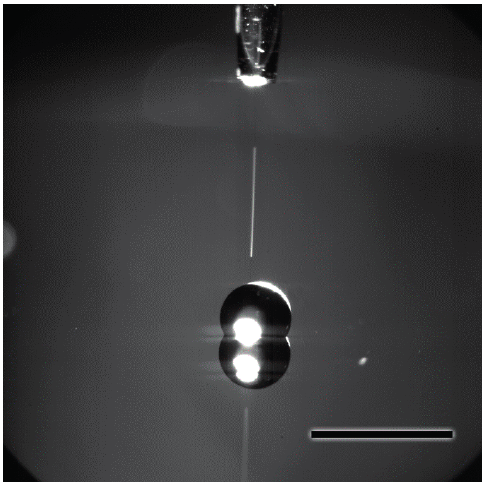
Figure 1. Image showing an optical microscope image of a single inkjet droplet (trail) being ejected from the inkjet printer head (top) onto the FTDS treated silicon substrate. The larger ensemble droplet on the surface contains several thousand individual drops. Note that on the reflective silicon surface we can see the mirror image of the drop. Scale bar in the image is 2 mm.